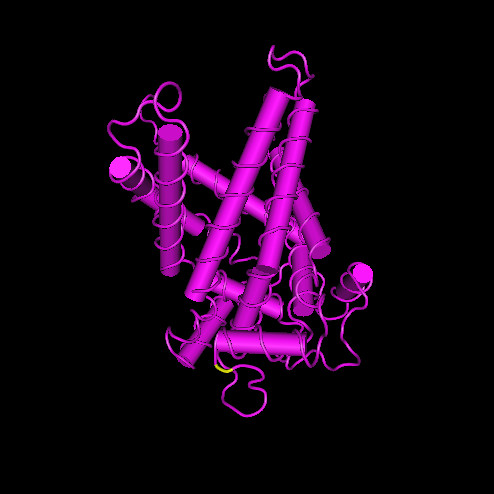
Three-dimensional representation of the UCP molecule according to the 3D structure of bovine mitochondrial adp-atp carrier (PDB id: 2c3e). The site under positive selection between the 5th and 6th α-helices is shown in yellow.